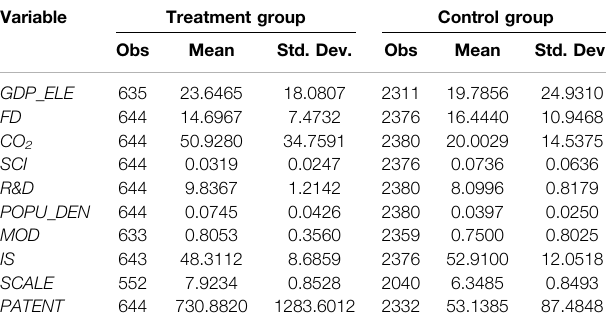
TABLE 3 | Grouping statistics of the main variables. Variable